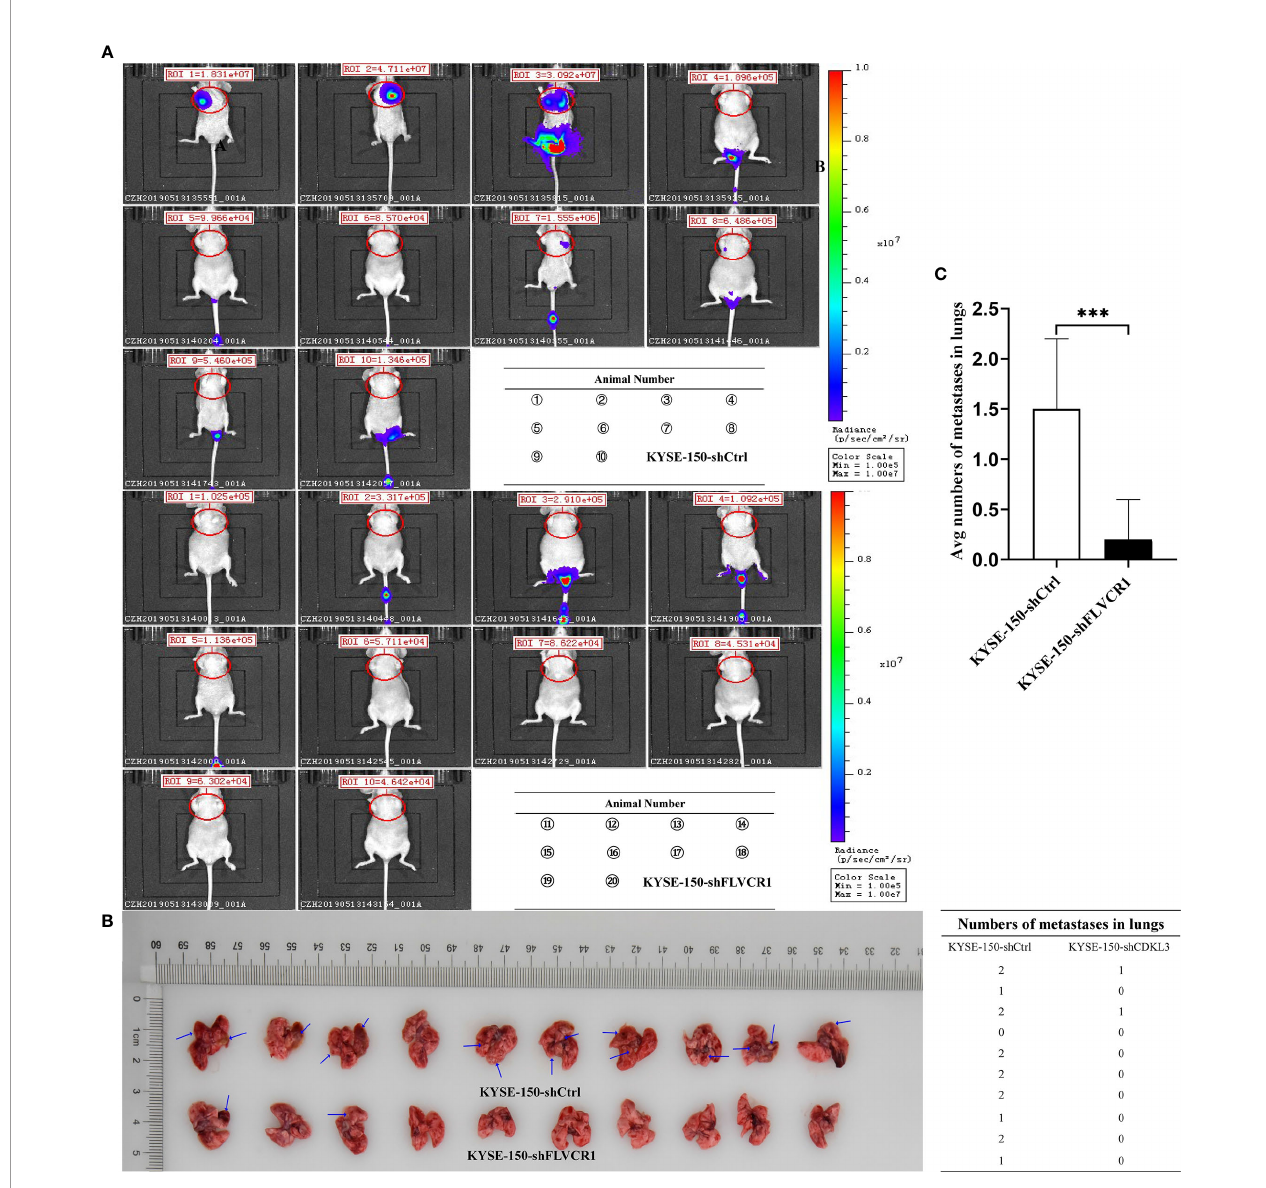
FIGURE 5 | FLVCR1 knockdown reduced tumor metastasis in vivo . (A) In vivo imaging of tumor-bearing mice. (B) FLVCR1 knockdown suppressed the metastatic potential of KYSE-150 cells in nude mice. Red arrow: metastases (C) Severely weakened fl uorescent radiant ef fi ciency was found in KYSE-150-shFLVCR1 cells that formed metastases compared to that of control mice, ***P <